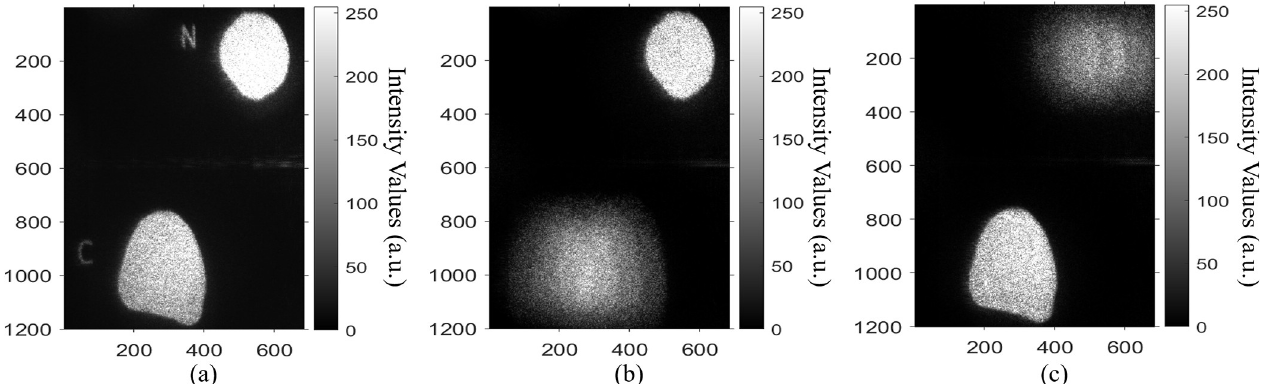
Fig 13. Discrimination between normal cell (N) and cancer cell (C) using a single 2D hologram (a) the two cells are focused, (b) the normal cell is focused and the cancer cell is out of focus, and (c) the cancer cell is focused and the normal cell is out of focus.